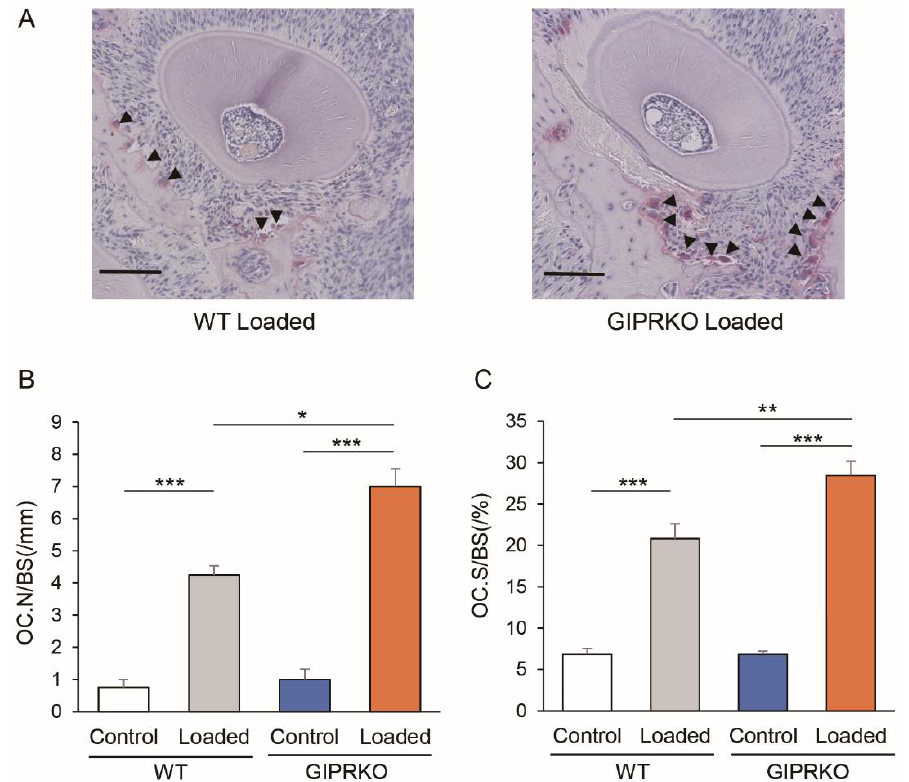
Figure 6. Evaluation of osteoclasts by TRAP staining. Comparison of the number of polynuclear TRAP-positive cells on the compression side of M1DP. ( A ) TRAP-stained micrographs of the exper- imental side of the WT and GIPRKO. Black arrow head points to osteoclast. (Scale bar: 100 µ m. ( B ) Comparison of changes in the osteoclast number (OC.N) and bone surface (BS). (* p < 0.05, *** p < 0.001). ( C ) Comparison of changes in the osteoclast surface (OC.S) and BS (** p < 0.01, *** p < 0.001) (WT: n = 5, GIPRKO: n = 4).